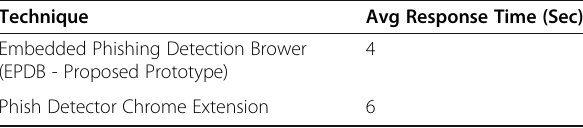
Table 4 A comparison of performance overhead Technique